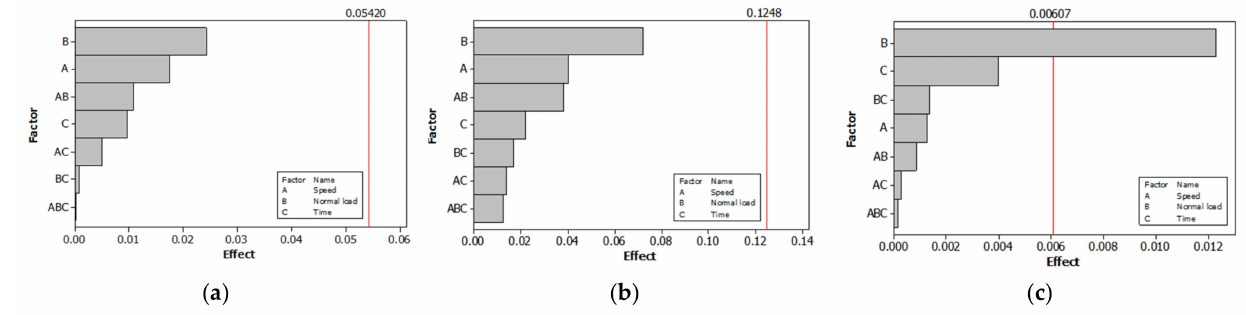
Figure 12. Pareto charts of the main effect of parametric interaction for ( a ) Al–1.3%Si, ( b ) Al–1.5%Si and ( c ) Al–13.5%Si